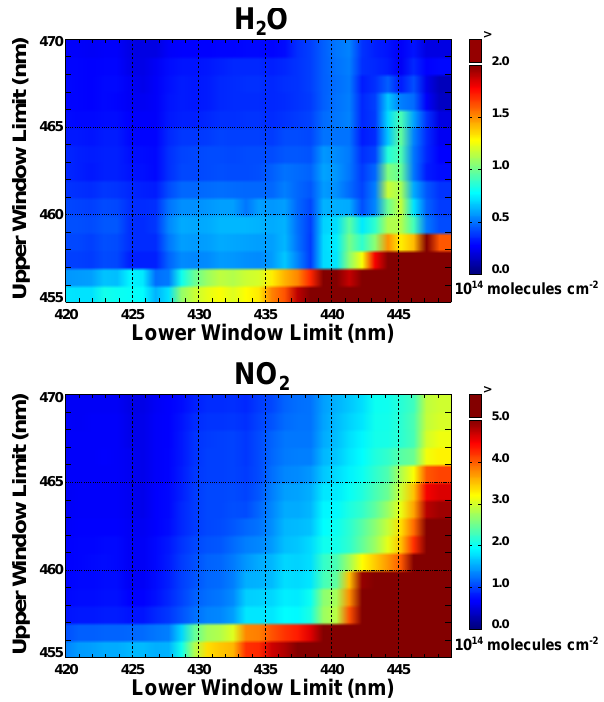
Figure 12. Estimate of mean glyoxal SCD error (moleculescm − 2 ) for all o10430 land pixels due to RCS uncertainties in water vapour (above) and NO 2